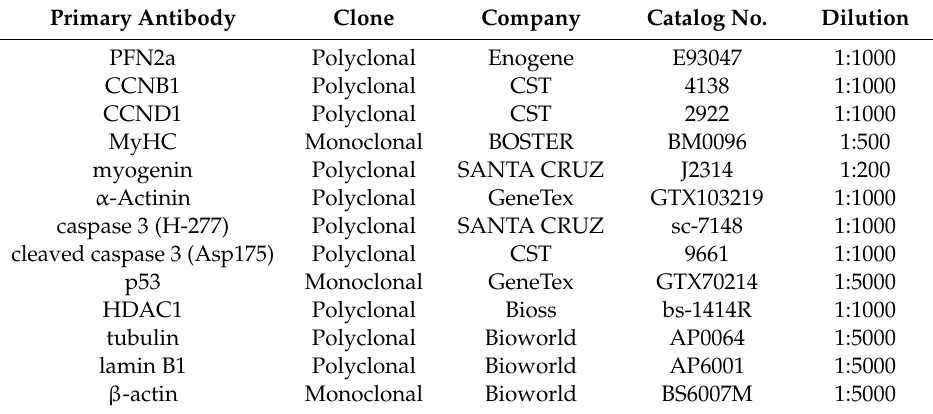
Table 4. Primary antibodies used in the study.